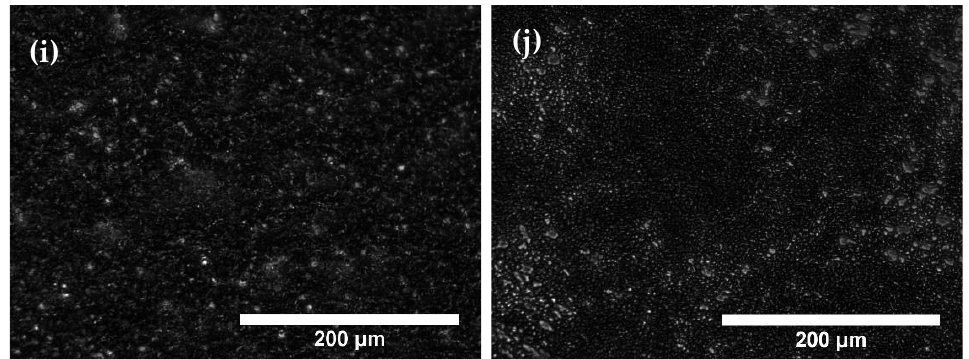
Figure 2. Phase-contrast images examples of the different tissue types, state and magnification: ( a ) Healthy liver at 10 × ; ( b ) Tumoral liver at 10 × ; ( c ) Healthy kidney at 20 × ; ( d ) Tumoral kidney at 20 × ; ( e ) Healthy ganglion at 40 × ; ( f ) Tumoral ganglion at 40 × ; ( g ) Healthy testicle at 10 × ; ( h ) Tumoral testicle at 10 × ; ( i ) Healthy brain at 20 × ; ( j ) Tumoral brain at 20 × .